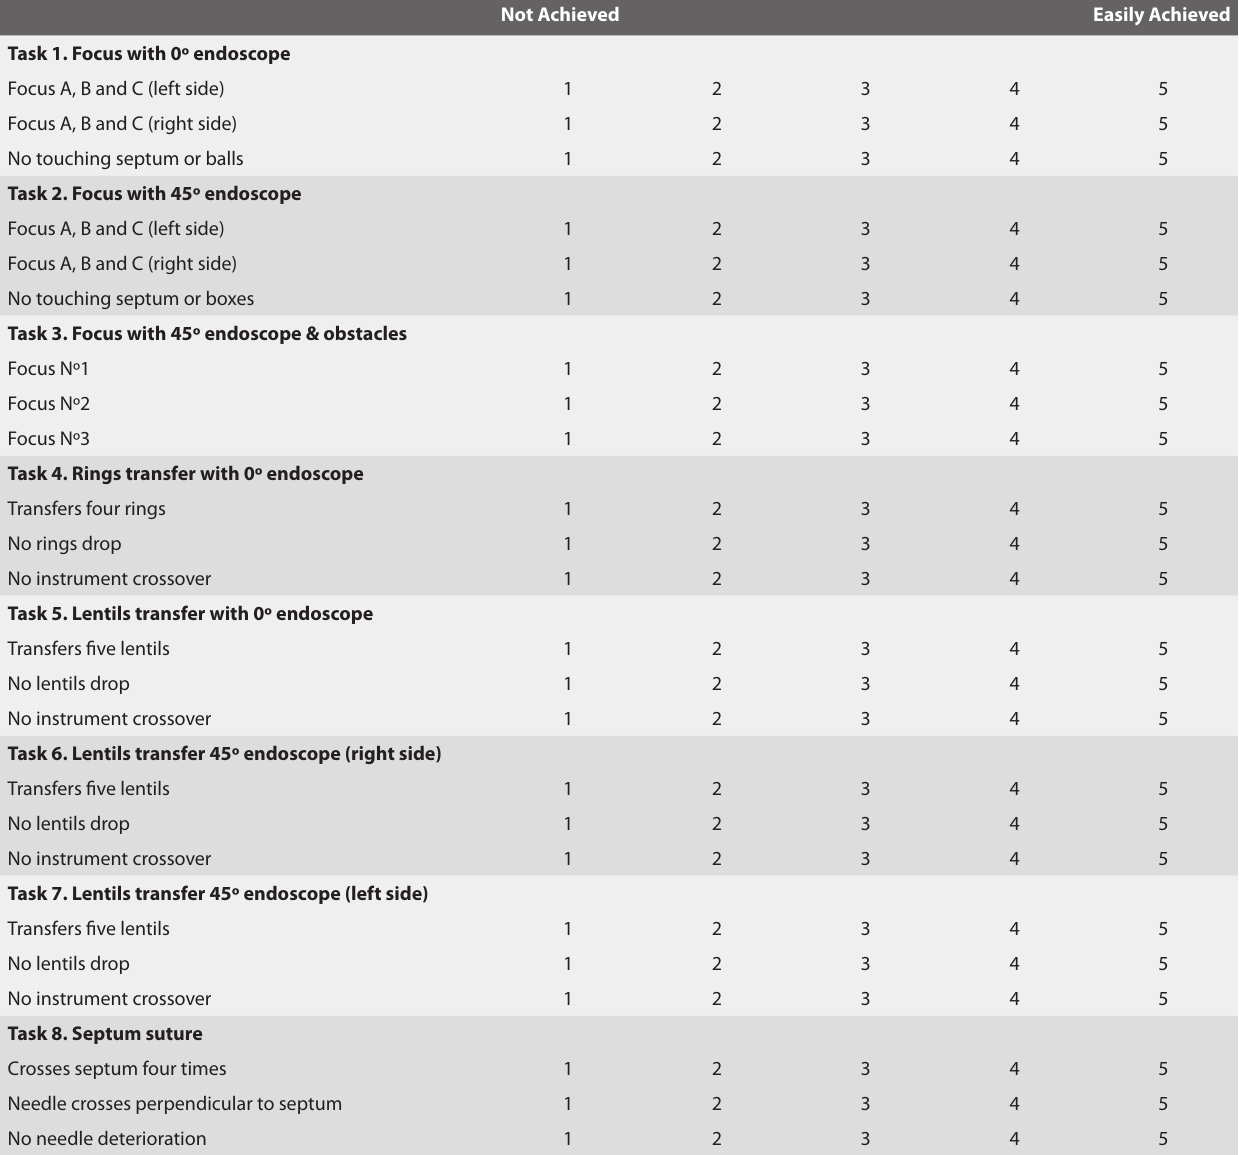
Table 1. Specific rating